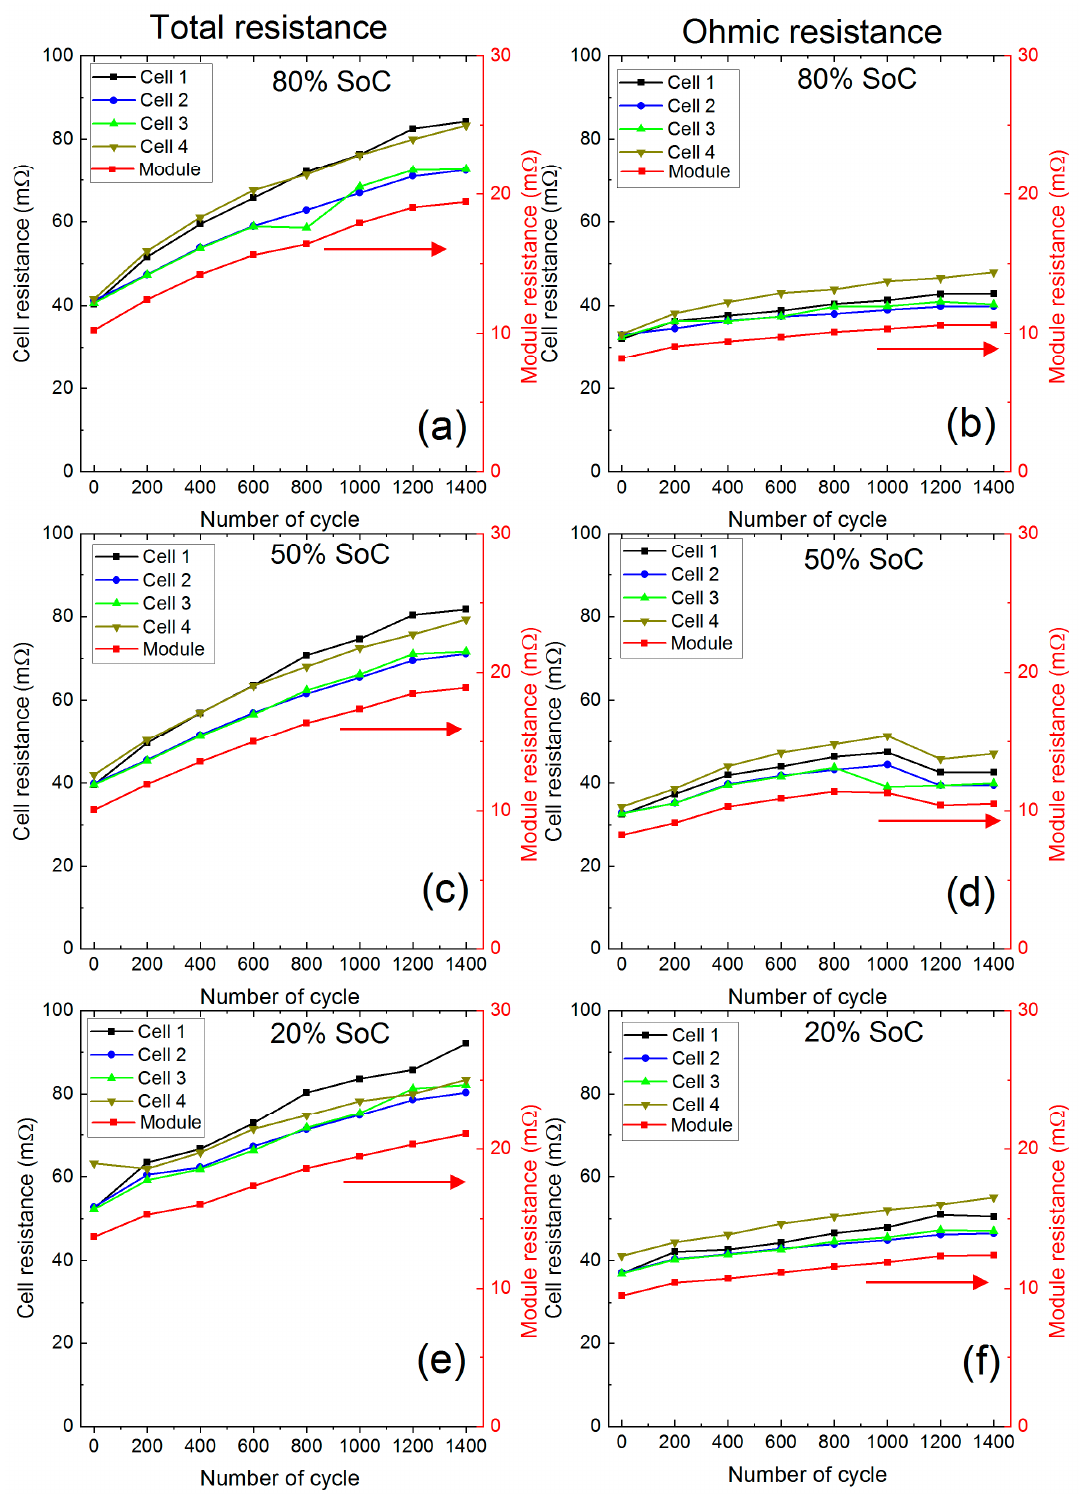
Figure 7. Resistance of the individual cells, measured at the three different of SoC (80, 50 and 20%) at 25 °C for cumulative 1400 cycles. The module resistance was calculated based on individual cell resistance. The first column shows the total resistance of individual cells and the 4P module at SoC ( a ) 80% ( c ) 50% and ( e ) 20%. The second column shows the corresponding ohmic resistance at SoC ( b ) 80% ( d ) 50% and ( f ) 20%.